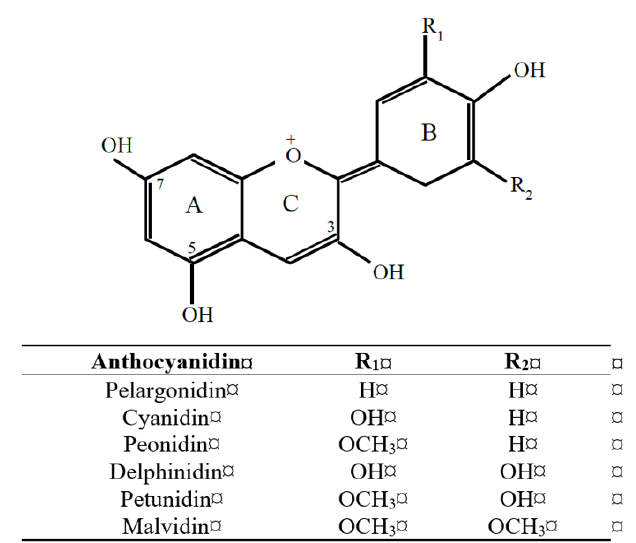
Figure 1. Generic structure of the six major anthocyanidins found in plant foods. Sugar conjugates of anthocyanidins (i.e., anthocyanins) occur most commonly via an O -linkage at carbon-3 and/or carbon-5. Phase 2 methylation, glucuronidation, sulfation is possible at all hydroxyl groups, giving rise to multiple positional isomers.